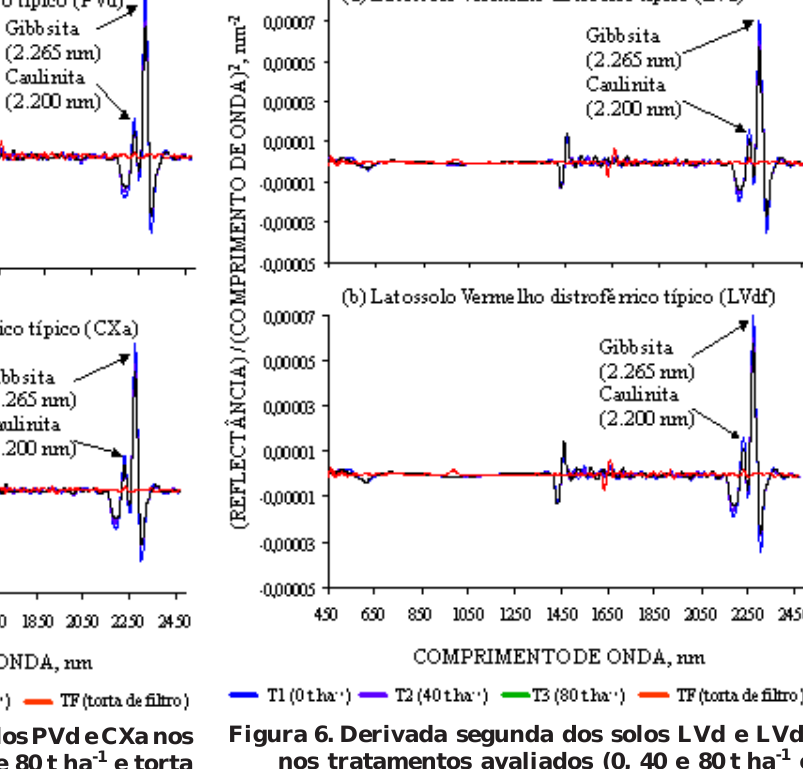
Figura 5. Derivada segunda dos solos PVd e CXa nos tratamentos avaliados (0, 40 e 80 t ha -1 e torta de filtro).